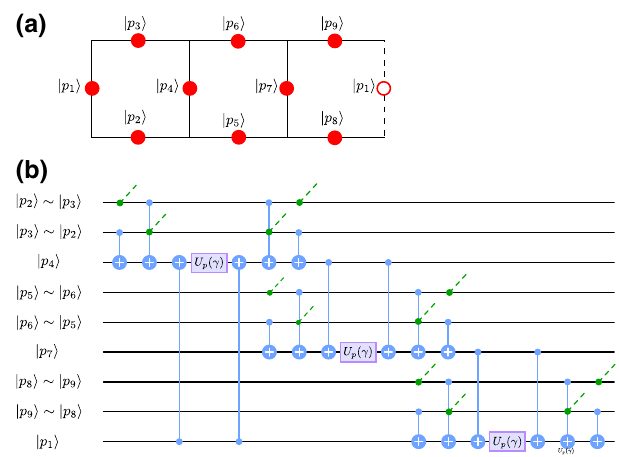
FIG. 12. (a) A stripe of the 3 × 3 lattice with periodic bound- ary conditions. (b) Quantum circuit to implement the plaquette operator e i γ B on all three plaquettes. The labeling of the qubit lines emphasizes that all the boundary qubits are shared with the plaquette stripes above and below. The partially depicted green CNOT gates are related to the simultaneous implementation of the same algorithm on the neighboring stripes: qubits 2, 3, 5, 6, 8, 9 also act as controls for the circuit in neighboring